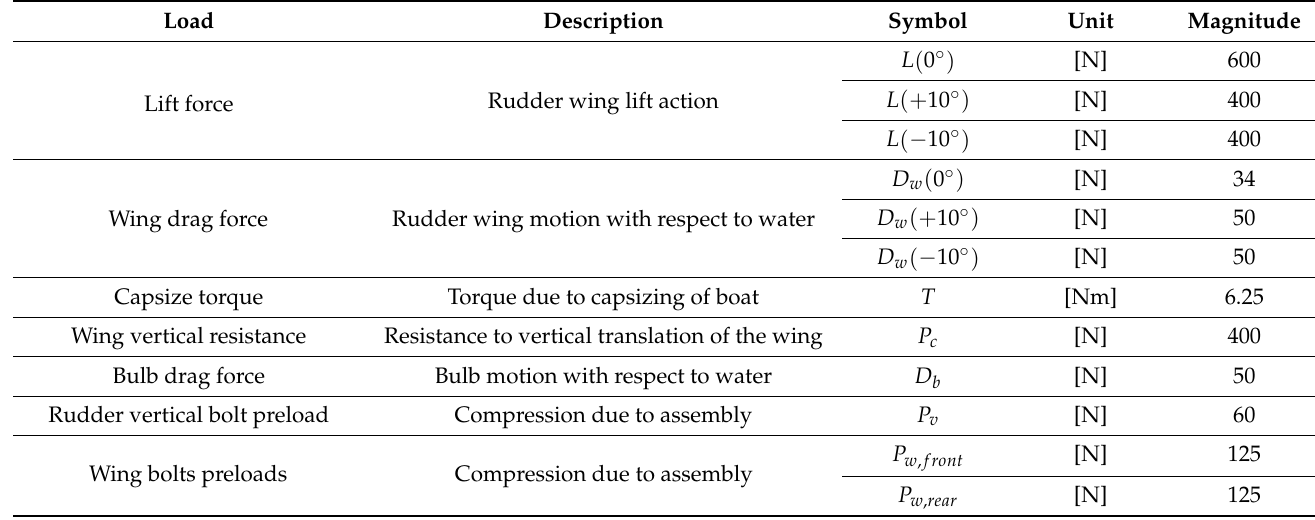
Table 1. The used load cases in the topological optimization